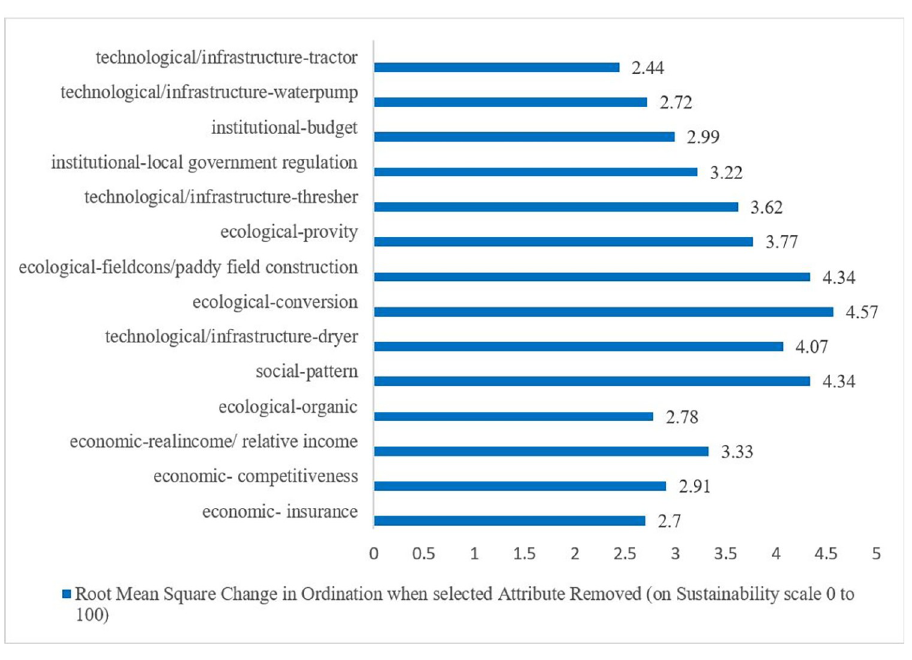
Fig 3. Leverage factors of rice production in Bandung